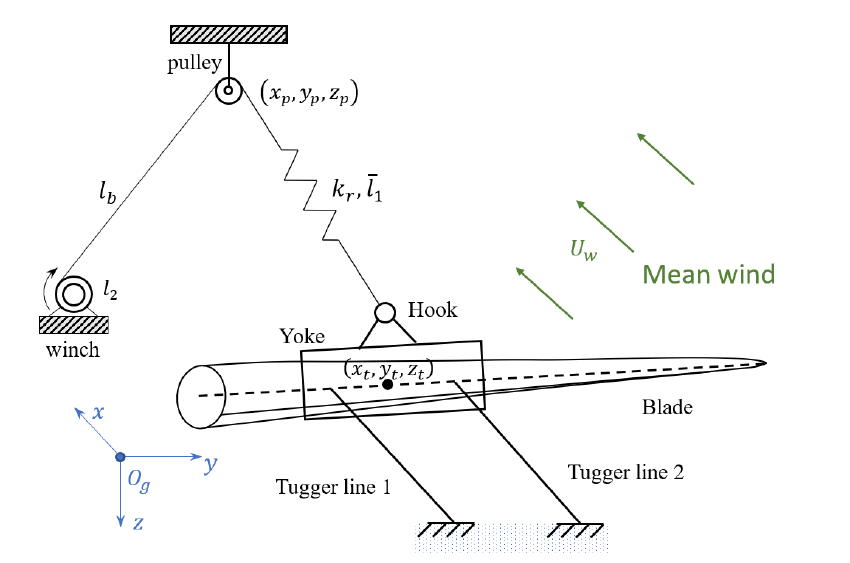
Figure 2. Free body diagram of the blade lifting operation.